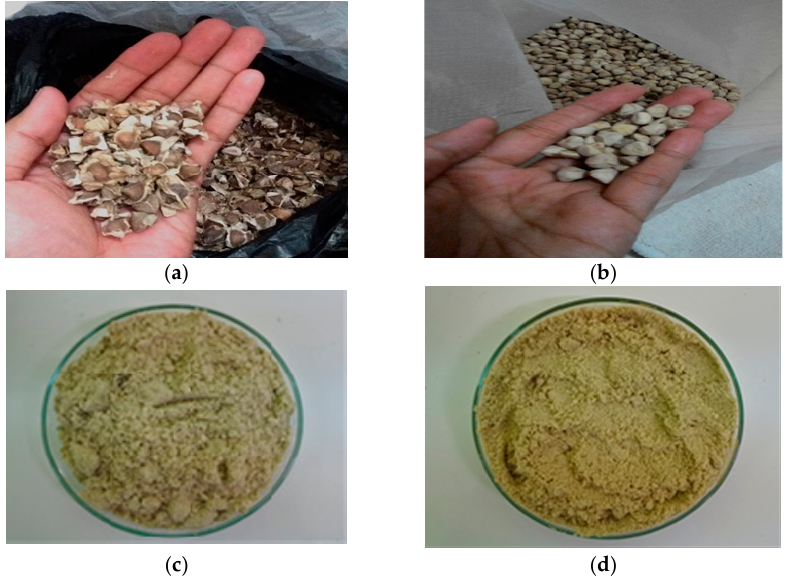
Figure 1. ( a ) M. oleifera seeds before peeling with hard and black shells, ( b ) M. oleifera white seeds after peeling, ( c ) M. oleifera seeds after powdered, and ( d ) M. oleifera seeds 100 mesh (about 149 µm).